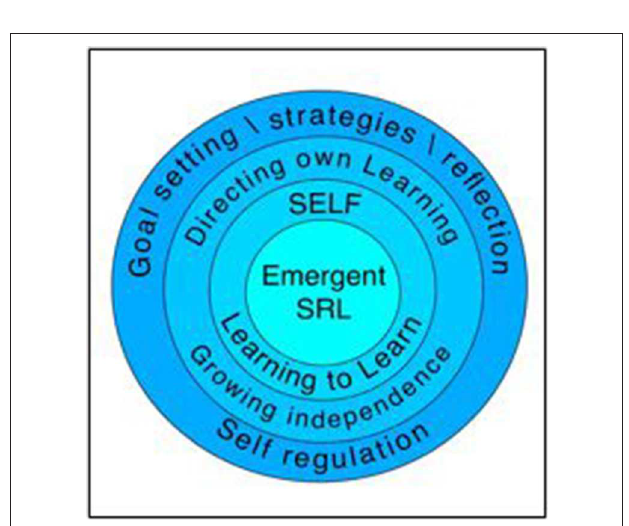
FIGURE 2 | The adapted Boekaerts’